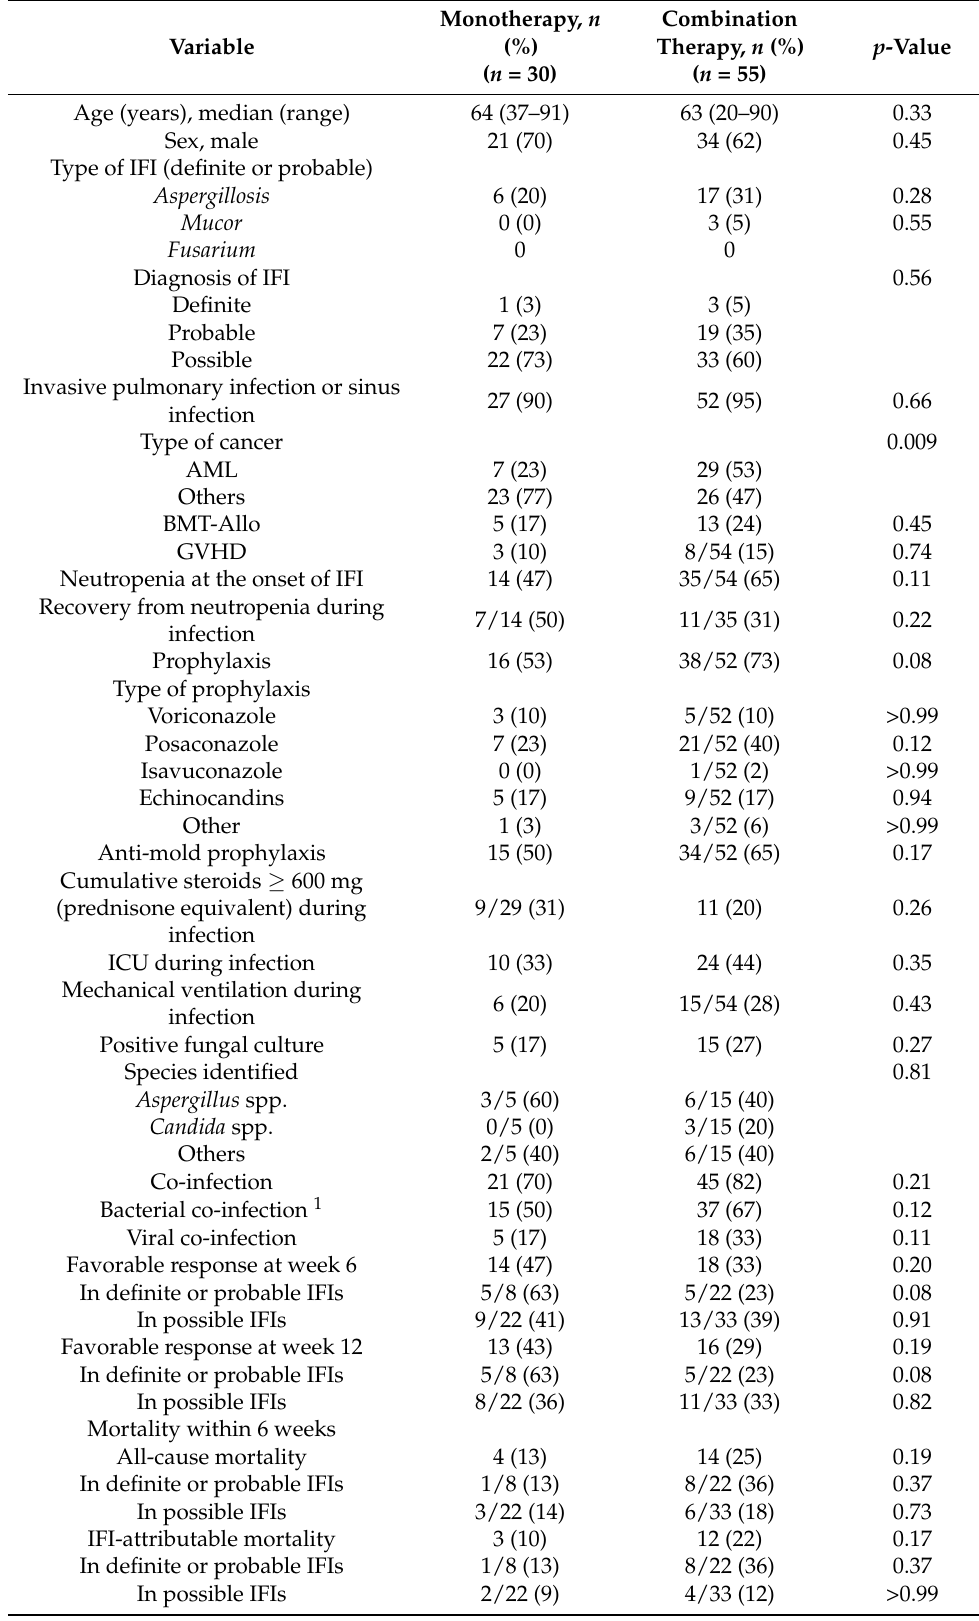
Table 2. Treatment